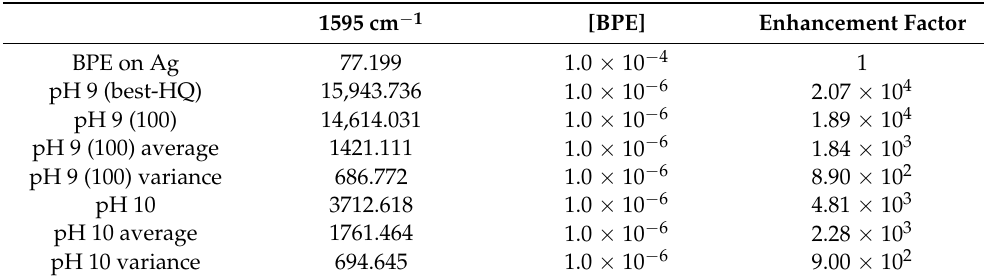
Table 5. Enhancement calculation for the Raman enhancement substrate at different pH.